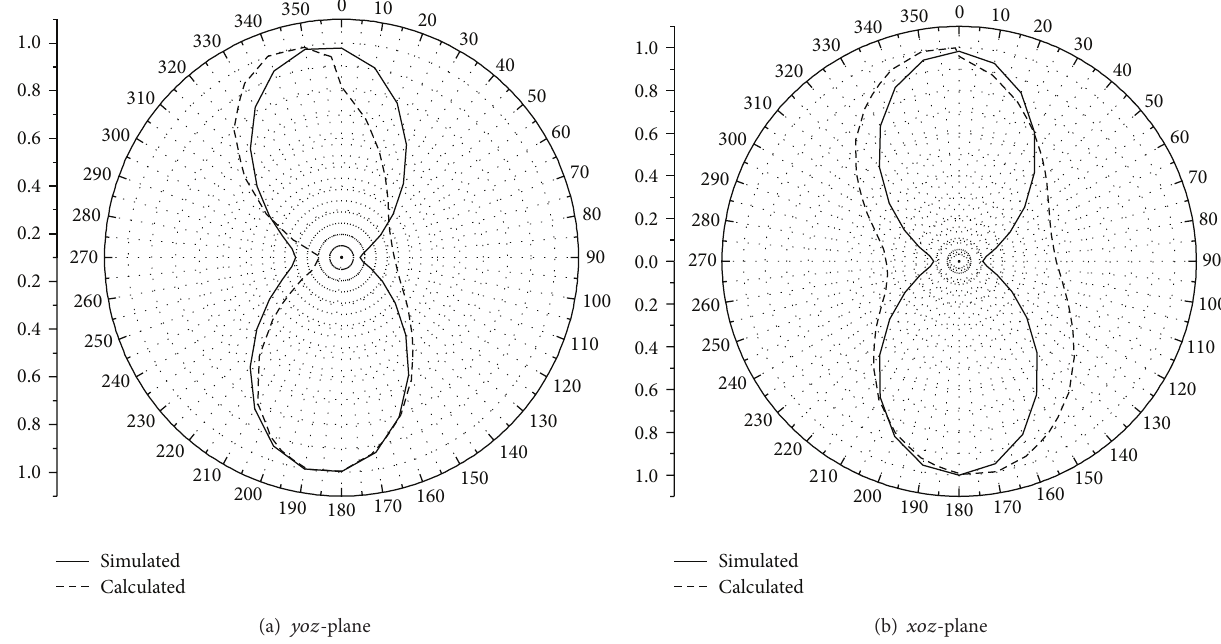
Figure 7: Simulated and calculated radiation pattern.